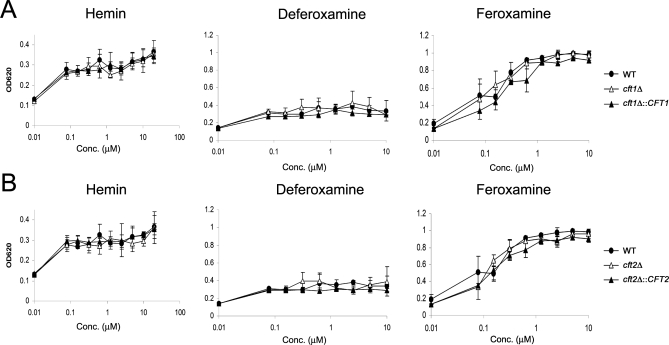
Non-Reductive Iron Uptake Systems Are Independent of Cft1 and Cft2(A) Iron-starved strains (the wild-type, the cft1 mutant and the CFT1 reconstituted strain) were inoculated into media containing heme, deferoxamine and feroxamine, which were added in stepwise 2-fold dilutions. The range of concentrations was between 20 μM and 0.78 μM (heme) and between 10 μM and 0.78 μM (deferoxamine and feroxamine); note that the scale on the X-axis is between 0.01 and 10 or 100 μM. In each graph, the OD620 reading at 0.01 μM indicates the level of growth in media without an added iron source starting at the standard inoculum density of 0.08. All cultures were incubated at 30°C and turbidity was measured after 72 h. Averages of three independent experiments are presented with bars representing the standard deviations.(B) The same experiments as shown in (A) were performed for the cft2 mutant and all strains showed similar patterns of growth.